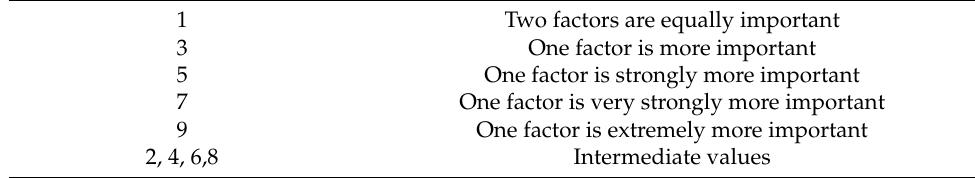
Table 1. Definition of comparative importance.